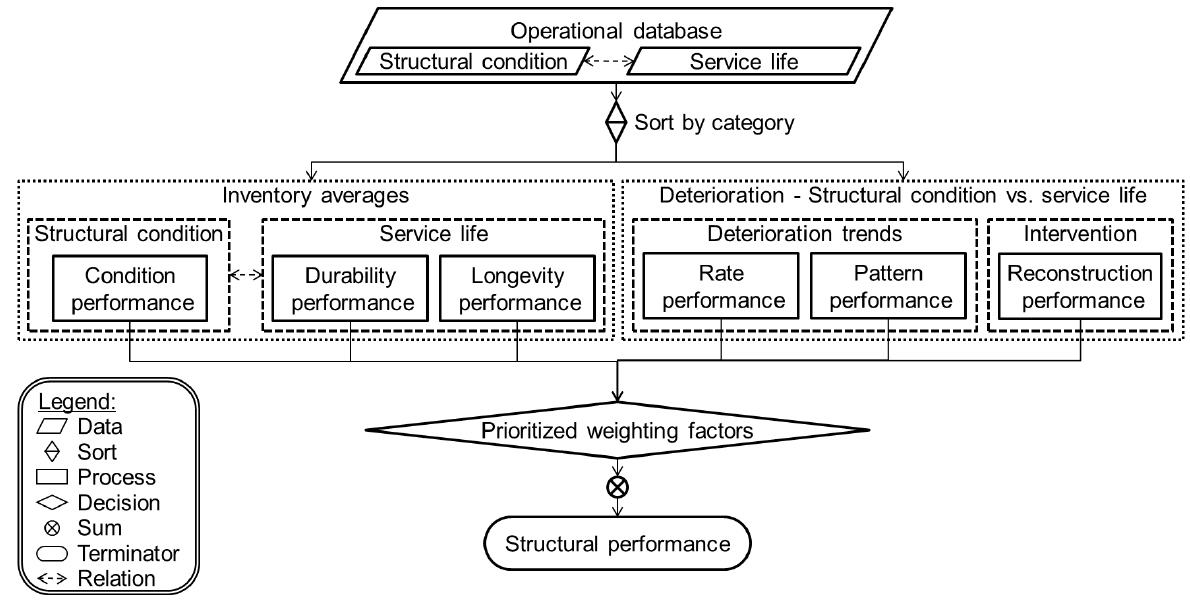
Figure 1. Structural performance.